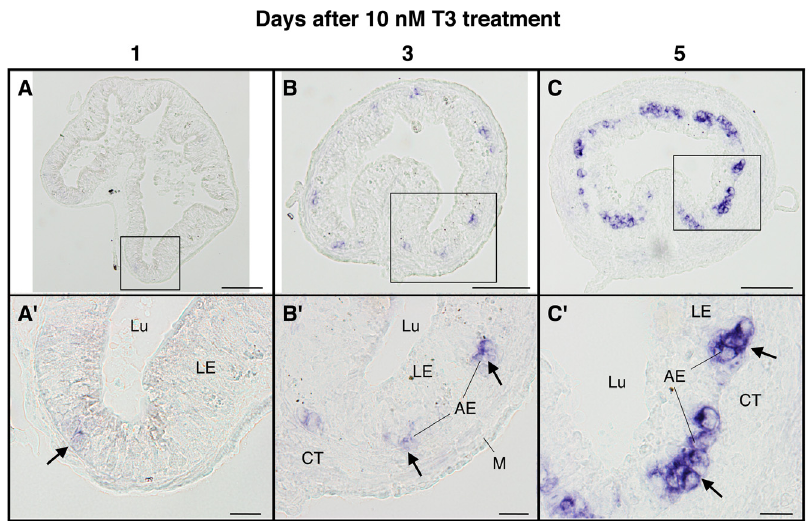
Figure 6. T3-dependent expression of LGR5 mRNA in the small intestine. Cross sections of the intestine from premetamorphic tadpoles (stage 54) treated with 10 nM T3 for 1 (A, A 9 ), 3 (B, B 9 ) and 5 days (C, C 9 ) were hybridized with LGR5 antisense probe. AE: adult epithelial cell including the progenitor/stem cell, CT: connective tissue, LE: larval epithelial cell, Lu: lumen, M: muscle layer. Scale bars are 100 m m (A–C) and 20 m m (A 9 –C 9 ),